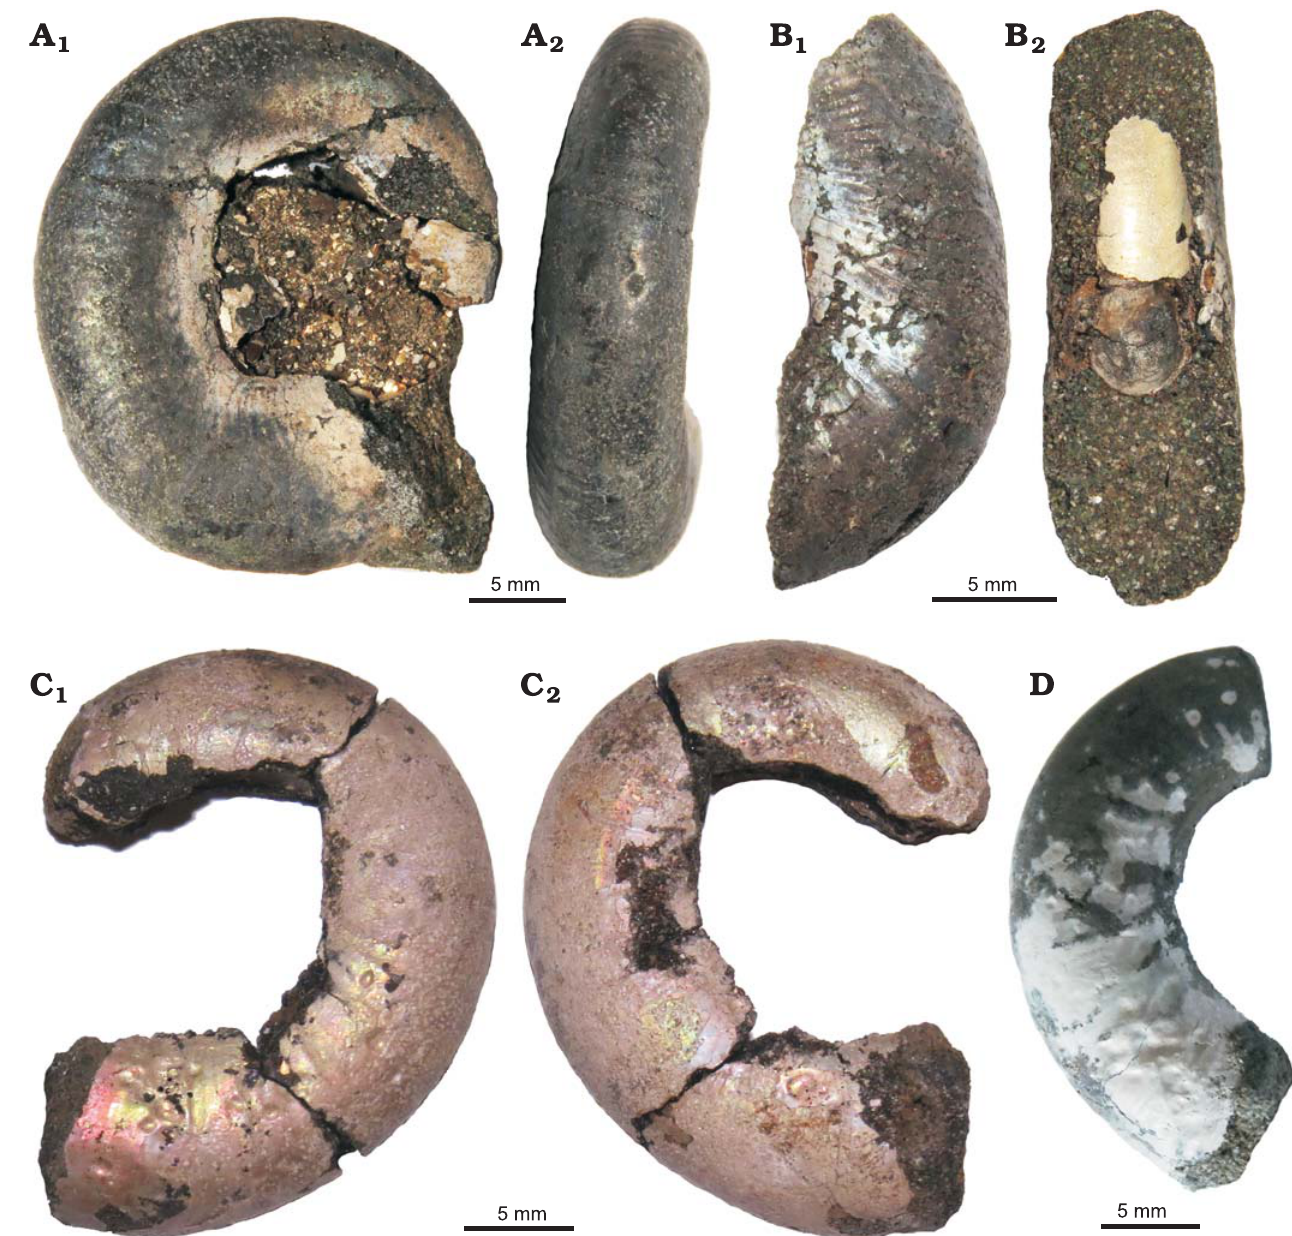
Fig. 9. Craspeditid ammonites Kachpurites fulgens (Trautschold, 1861) from the Late Volgian, Kachpurites fulgens Zone, Moscow region, Central Russia, Eganovo (A, B) and Mnevniki (C, D) localities; shells with pits and epizoans, lateral (A 1 , B 1 , C, D) and dorsal (A 2 , B 2 ) views. A . MSU 118/7, abnormal “scaphitoid” shell shape. There are several pits on the ventral side of the shell (A 2 ). B . MSU 118/16, fragment of the abnormal shell. The fragment of bivalve shell which caused distortion of the shell growth can be seen on the dorsal side (B 2 ). There are no pits on this specimen. C . MSU 118/8, body chamber with pits on both sides of the shell. D . MSU 118/9, fragment of the body chamber with pits, many of them are merged with each